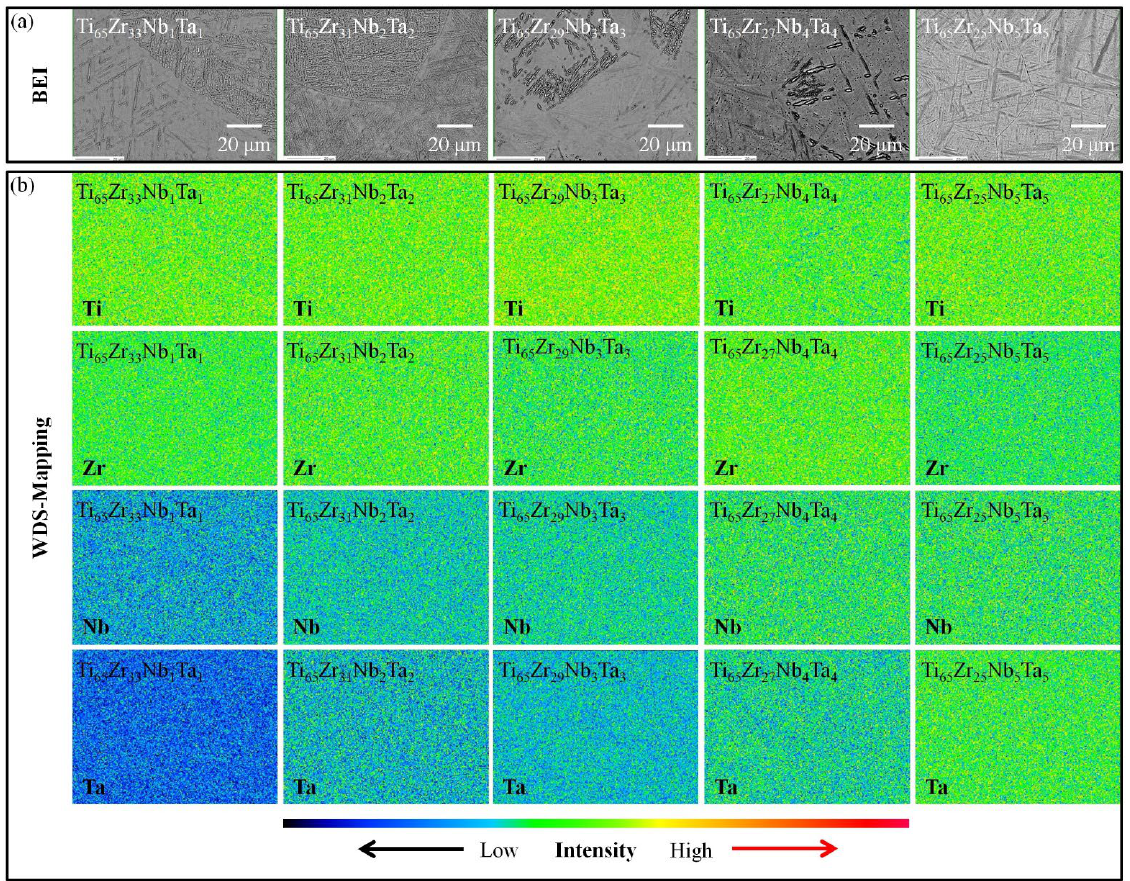
Figure 5. Electron probe microanalysis images of the Ti–Zr–Nb–Ta MEAs after ST: ( a ) backscattered electron imaging and ( b ) wavelength dispersive spectroscopy mapping.